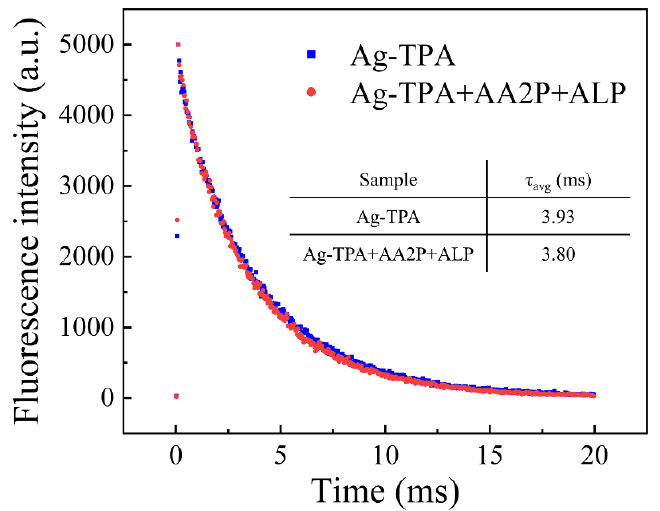
Figure 6. Fluorescent lifetimes of Ag-TPA CPNs in the absence and presence of ALP. Note: c (ALP): 10 mU/mL; c (AA2P): 0.25 mM; Ag-TPA CPN solution: 50 μ L; λ ex : 320 nm; λ em : 490